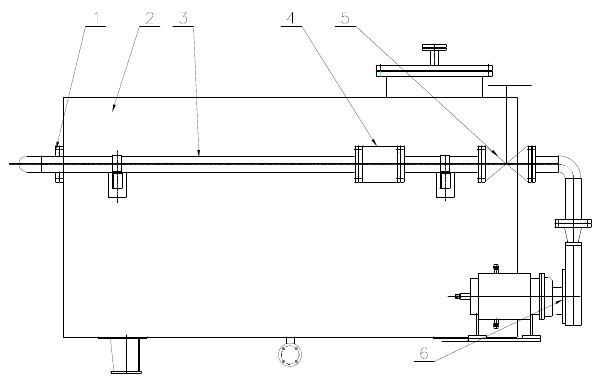
Figure 20. Test bed. 1. Pipeline export. 2. Water tank. 3. Pipeline. 4. Electromagnetic flowmeter. 5.